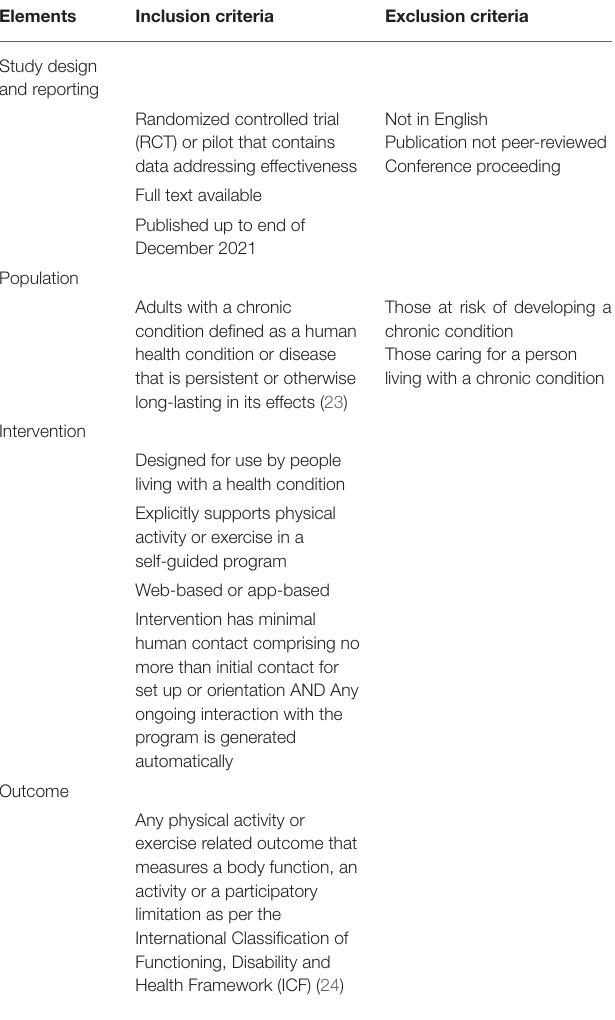
TABLE 1 | Eligibility criteria of papers.